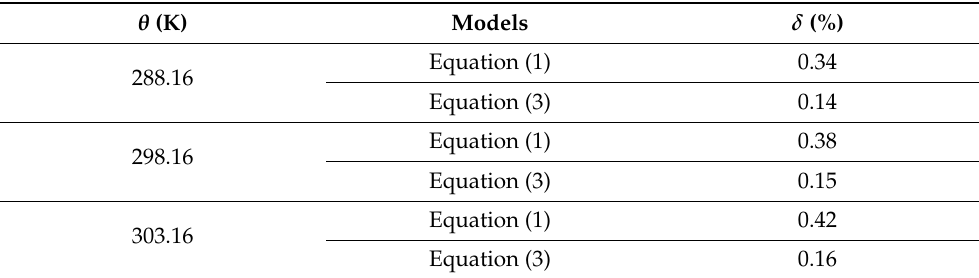
Table 3. The maximum deviation between models described by Equations (1) and (3) and experimen- tal